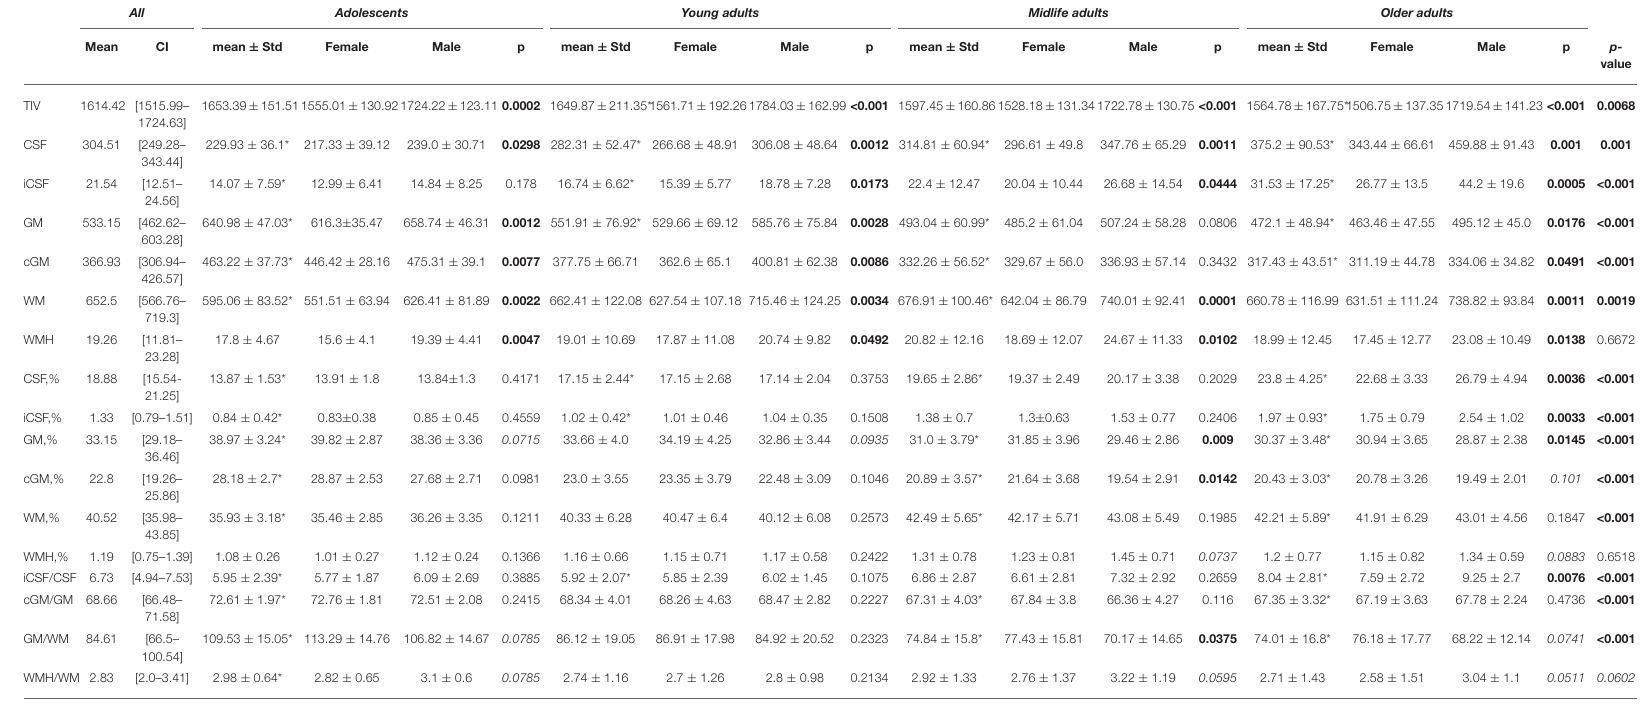
TABLE 1 | Skull and brain morphometry in overall study cohort and with regard to age group and